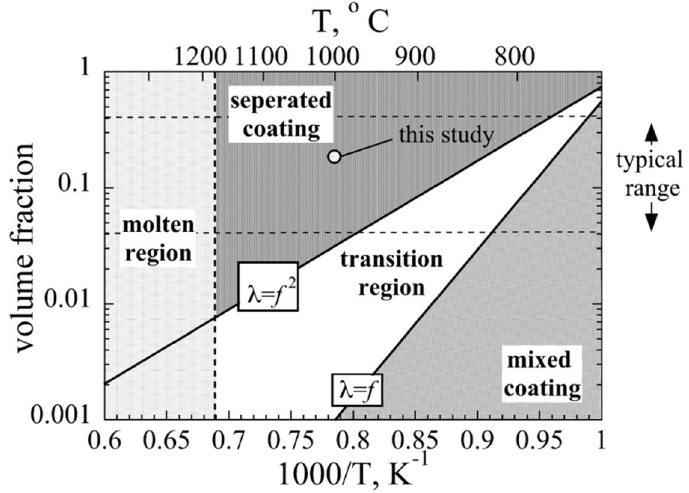
Figure 5. Coating structure growth map as a function of temperature, T , and binder volume fraction, f . Separated, i.e., two-part, structures are predicted at high T and high f , and mixed coatings at low T and low f .